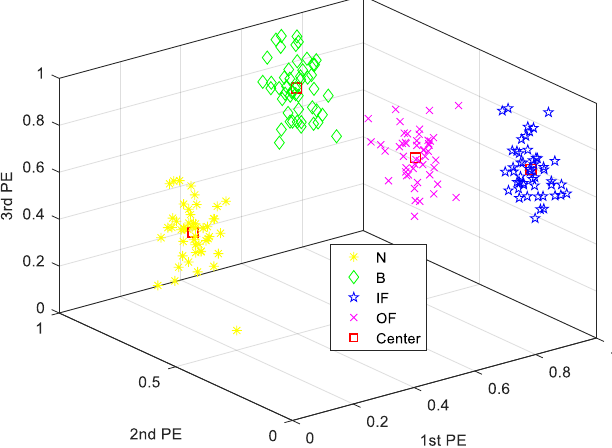
Figure 4. The spatial graph of Gath–Geva (GG) clustering for permutation entropy.